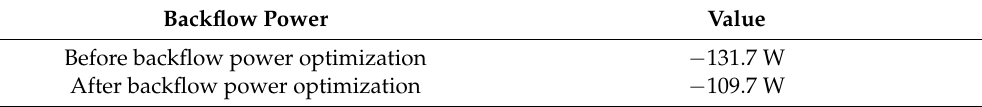
Table 8. Backflow power of